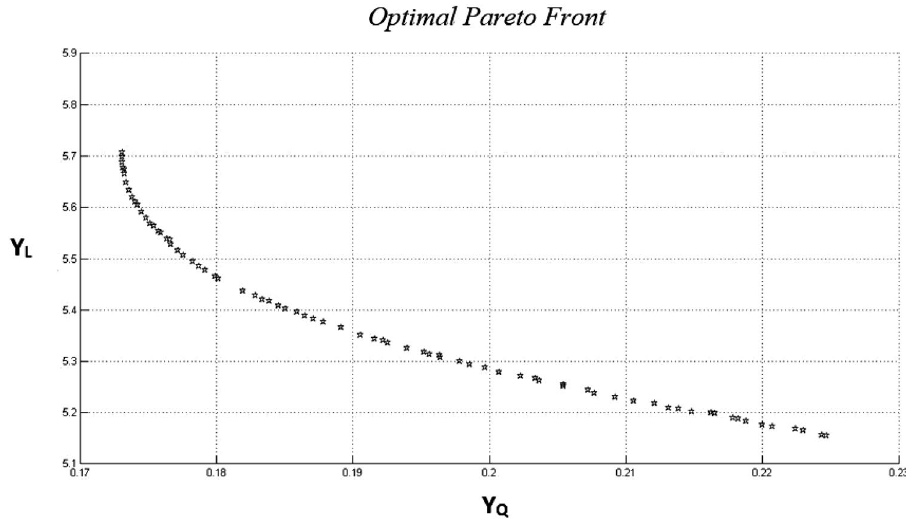
Fig. 15 Optimal Pareto front for the total fitness function of the case